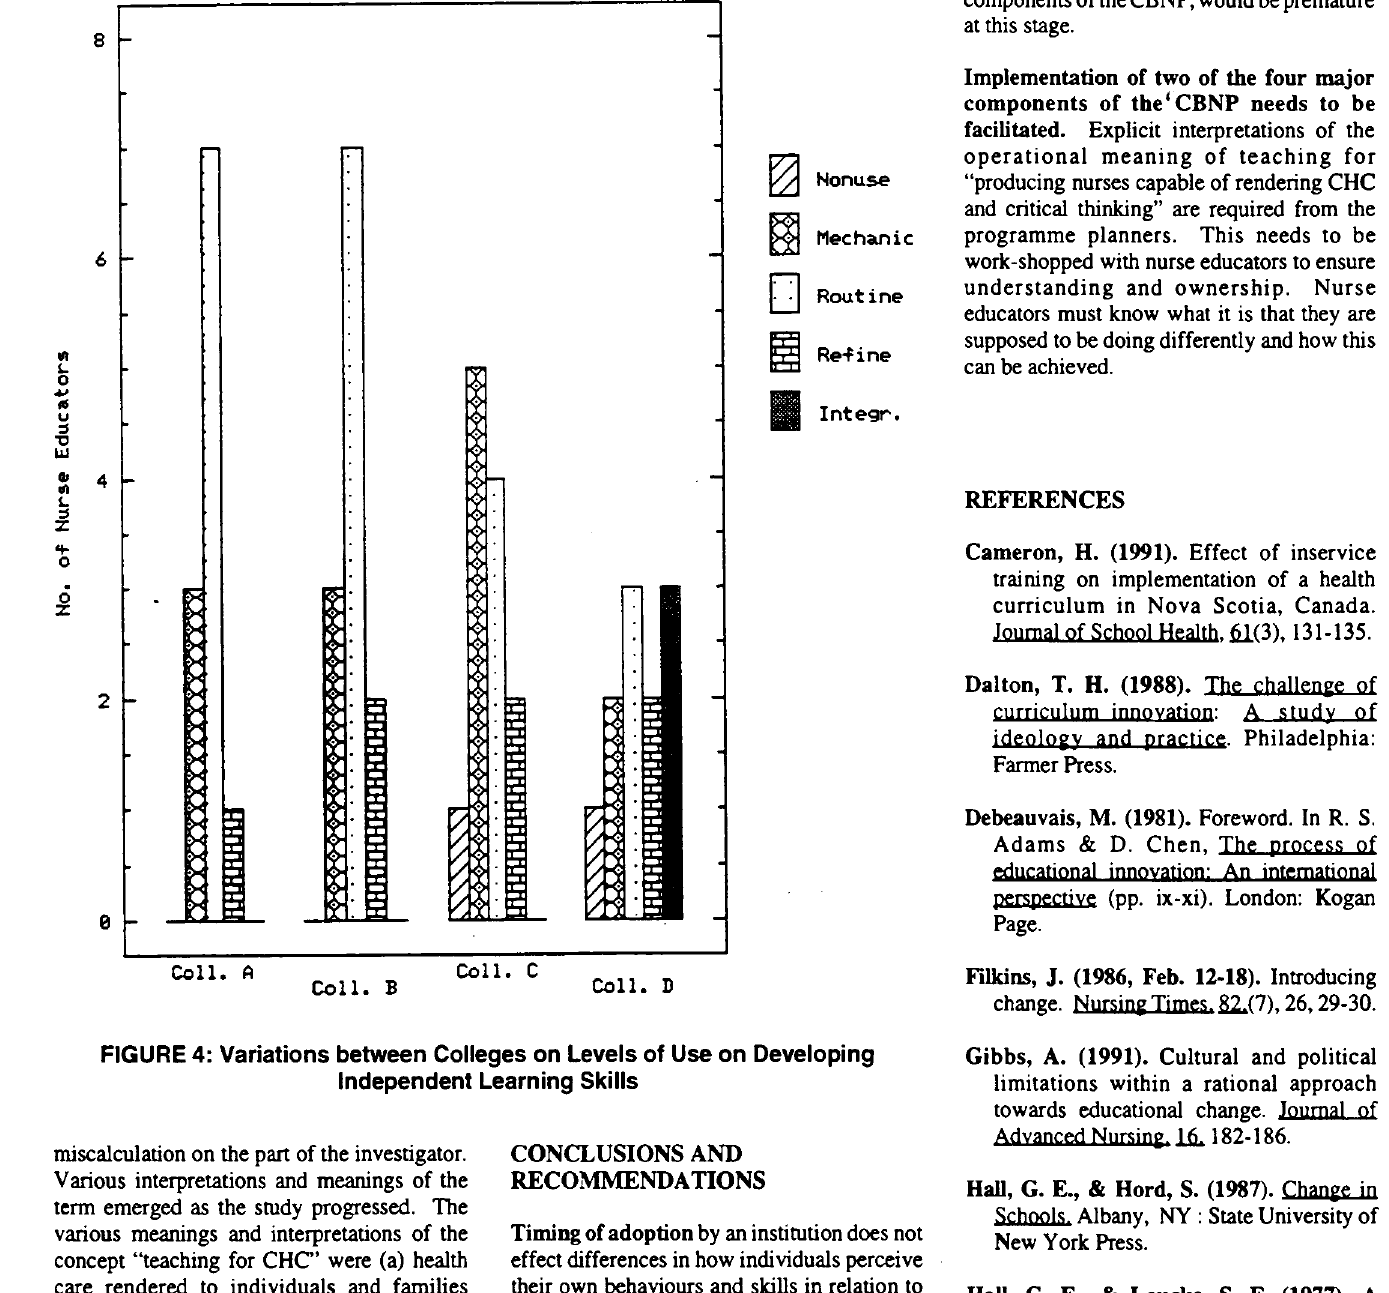
FIGURE 4: Variations between Colleges on Levels of Use on Developing Independent Learning